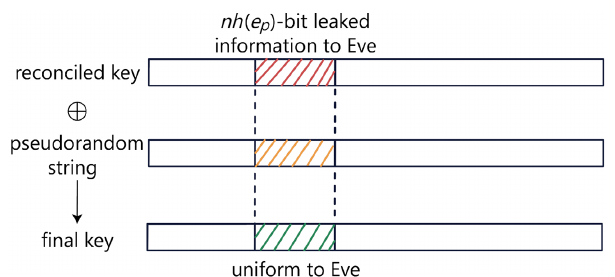
FIG. 3. An illustration of the pseudorandomness property of (cid:15) d · M . The red-shaded area in the reconciled key denotes the nh ( e p ) -bit information leakage to Eve. This leaked information can be the bit values of the key or the parity information about the key. After the XOR of the reconciled key and the pseudorandom (cid:15) string d · M , the reconciled key becomes the final secure key and is uniformly distributed from Eve’s point of view. That is, Eve’s knowledge about the key is removed. As a corollary, the corre- sponding yellow-shaded area in the pseudorandom string should be uniform to Eve as